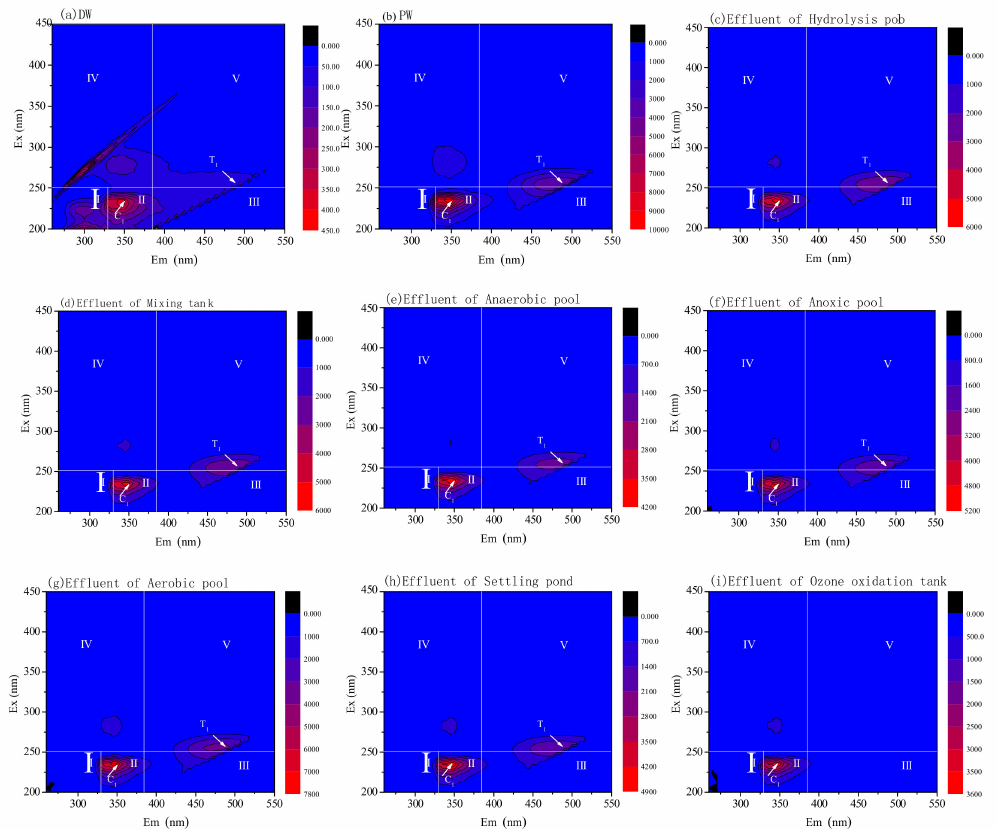
Figure 7. The excitation emission matrix spectra of each process e ffl uent for post-ozone (50% PW). (( a ) DW sample; ( b ) PW sample; ( c ) E ffl uent of Hydrolysis pool sample; ( d ) E ffl uent of Mixing tank sample; ( e ) E ffl uent of Anaerobic pool sample; ( f ) E ffl uent of Anoxic pool sample; ( g ) E ffl uent of Aerobic pool sample; ( h ) E ffl uent of Settling pool sample ( i )) E ffl uent of Ozone oxidation tank